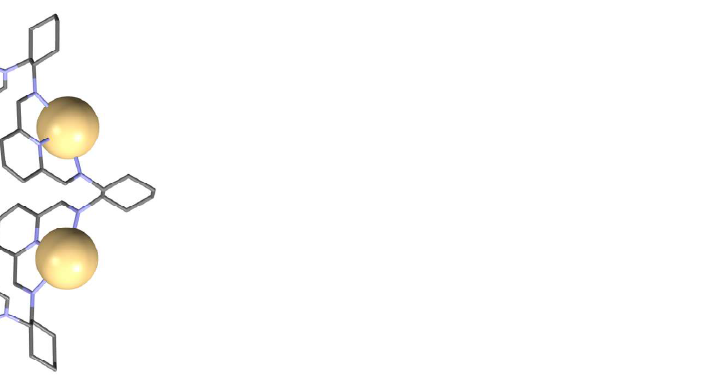
Figure 31. Molecular structure of hexanuclear Cd(II) complex of 62 (Cd atoms in spacefill representa- tion, hydrogen atoms and chloride anions are omitted).